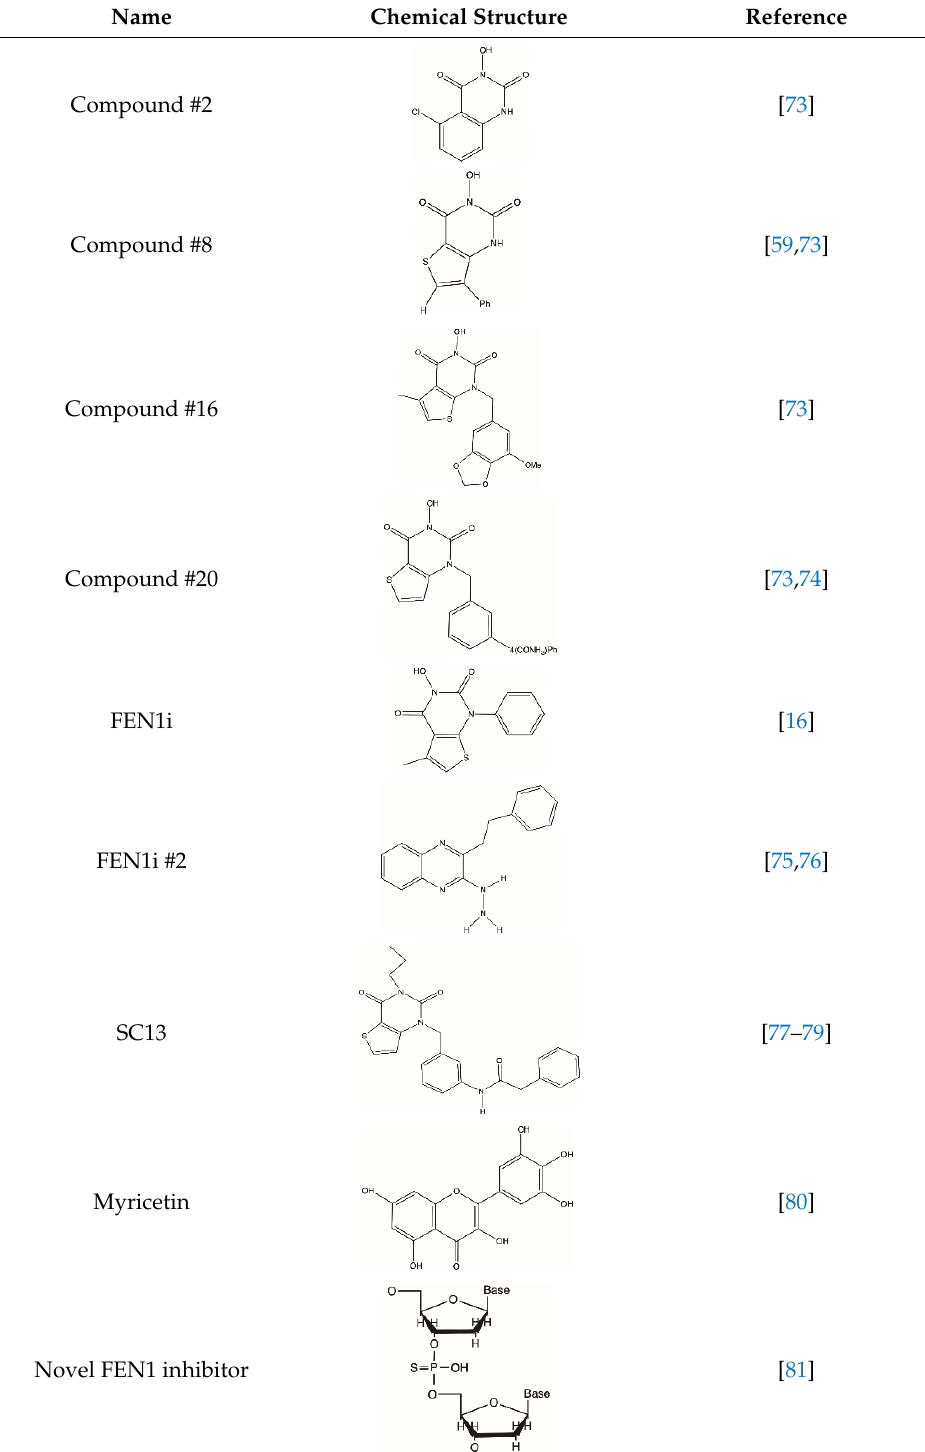
Table 1. Recently developed FEN1 inhibitors.